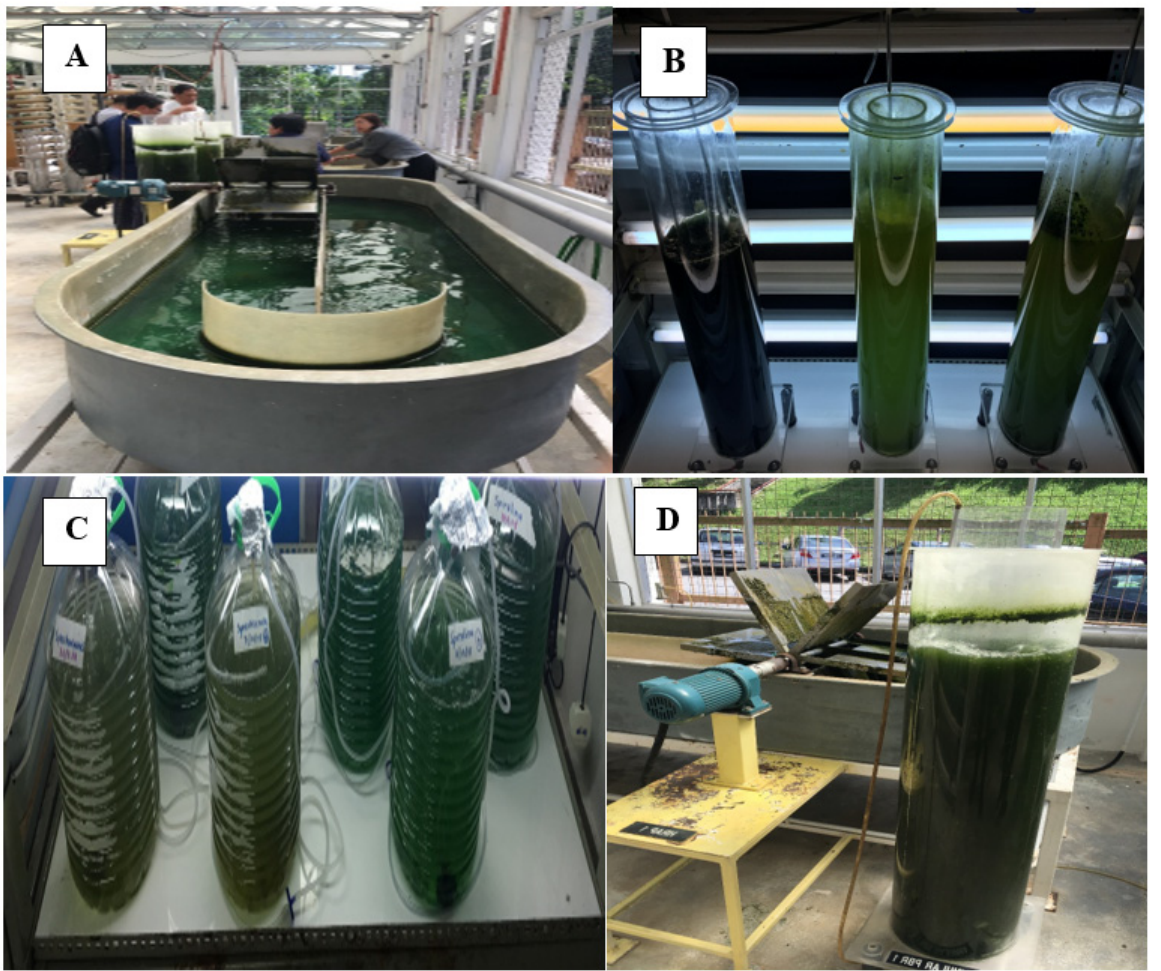
Figure 2. Lab scale microalgae cultivation types. ( A ) raceway photobioreactor; ( B ) indoor annular column photobioreactor; ( C ) microalgae culture in bottles with light and oxygen in Scientific laboratory; ( D ) open annular photobioreactor (Courtesy: Dr. Adibi Rahiman Md Nor, University Malaya).